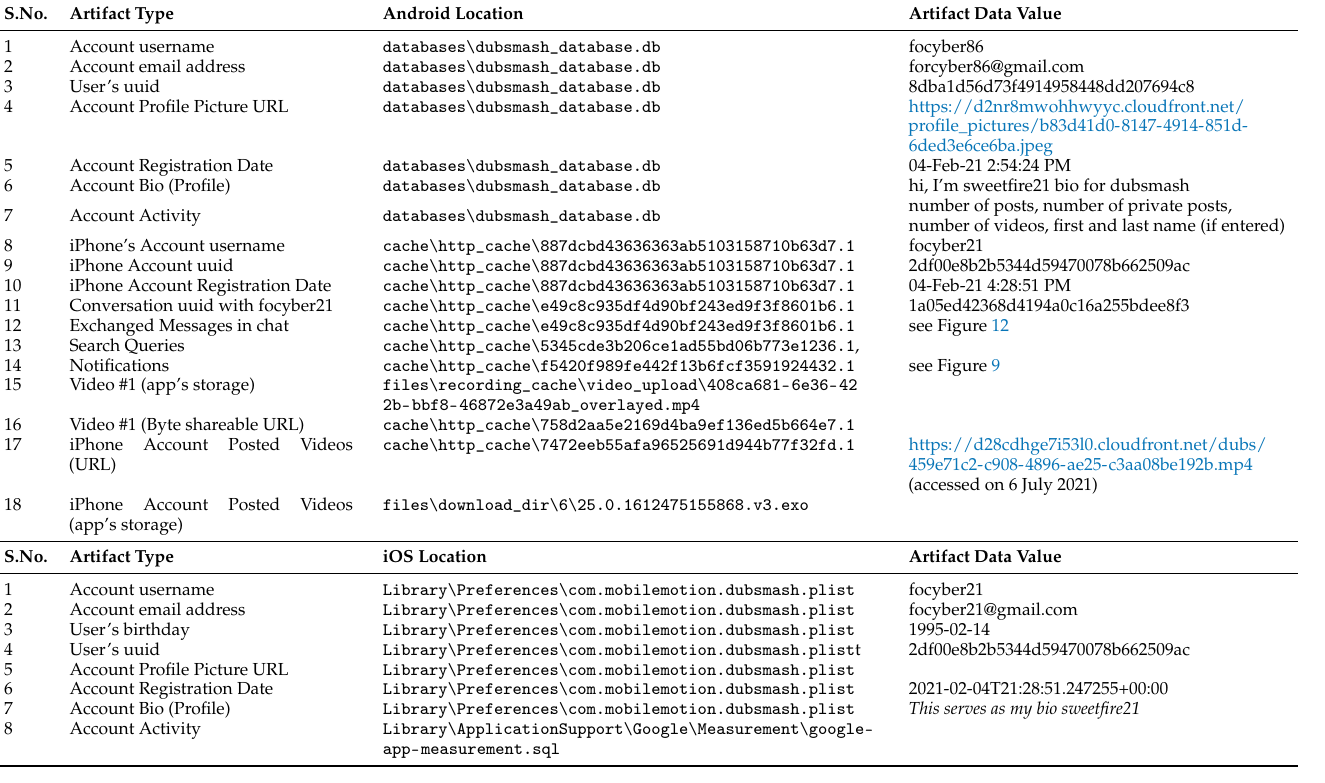
Table 6. Dubsmash Android and iPhone artifacts.